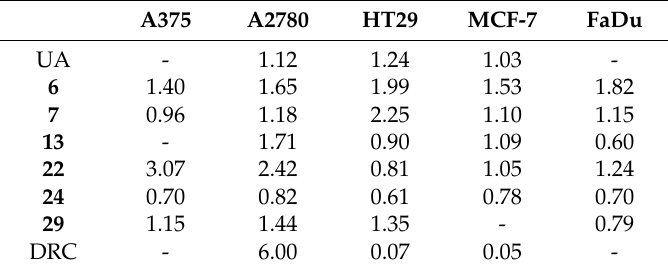
Table 2. Selectivity of selected UA-DOTA conjugates ( 13 , 22 , 24, and 29 ), DOTA precursors ( 6 , 7 ), ursolic acid (UA) and doxorubicin hydrochloride (DRC): Selectivity index (SI) is defined as: SI = EC 50 (NIH 3T3) / EC 50 (tumor cell